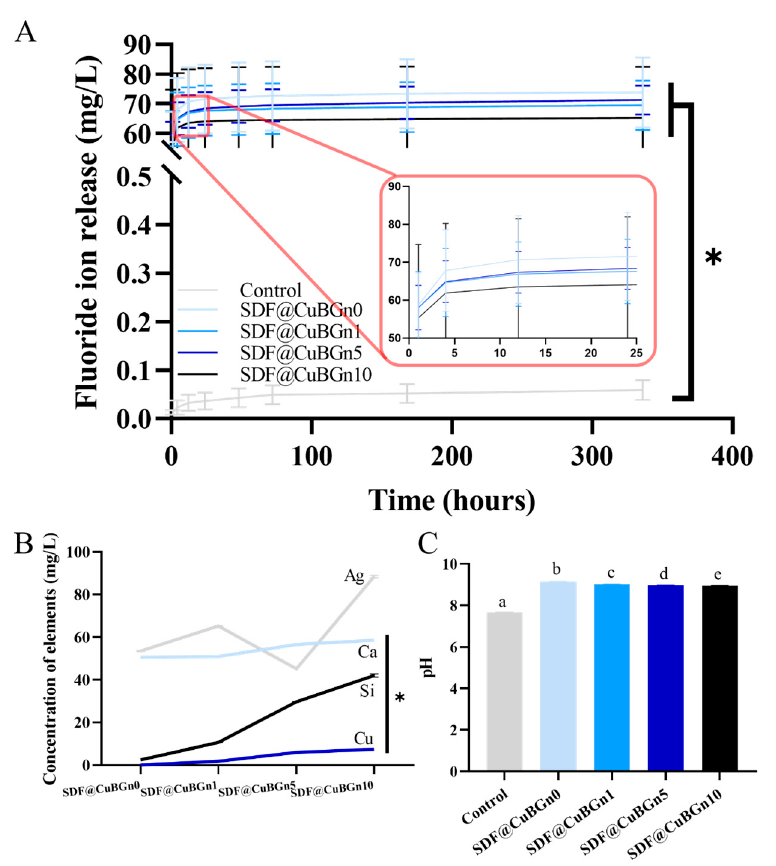
Figure 4. Physicochemical analysis (ion release tests for F, Ca, Cu, and Si and pH measurements) of SDF@CuBGn-applied HA discs. ( A ) Accumulated fluoride ion release test. More than 90% of fluoride was released within 4 h, and all test groups presented significantly higher (at least 1000 times) fluoride ion release than the control group ( p < 0.05). CuBGn did not affect the result. ( p > 0.05). ( B ) Ag, Ca, Cu, and Si ion concentrations and ( C ) pH measurements of artificial saliva with SDF@CuBGn-applied discs in it for 24 h. As the CuBGn increased, the concentration of released Ca, Cu, and Si ions also increased ( p < 0.05) without affecting Ag ion release ( p > 0.05), and the pH of the extracted